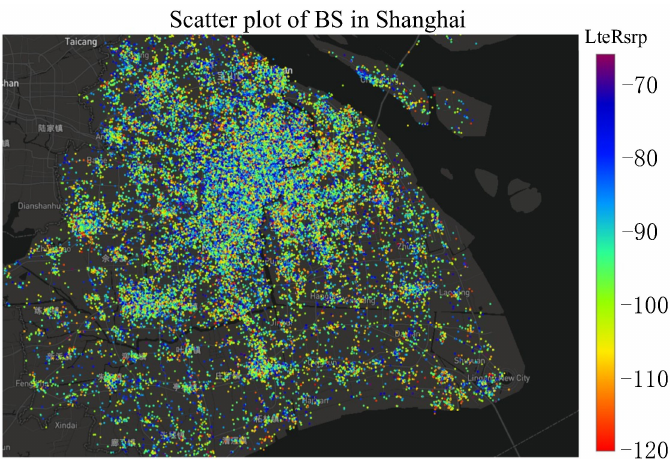
Figure 13. Scatter plot of samples of whole city.